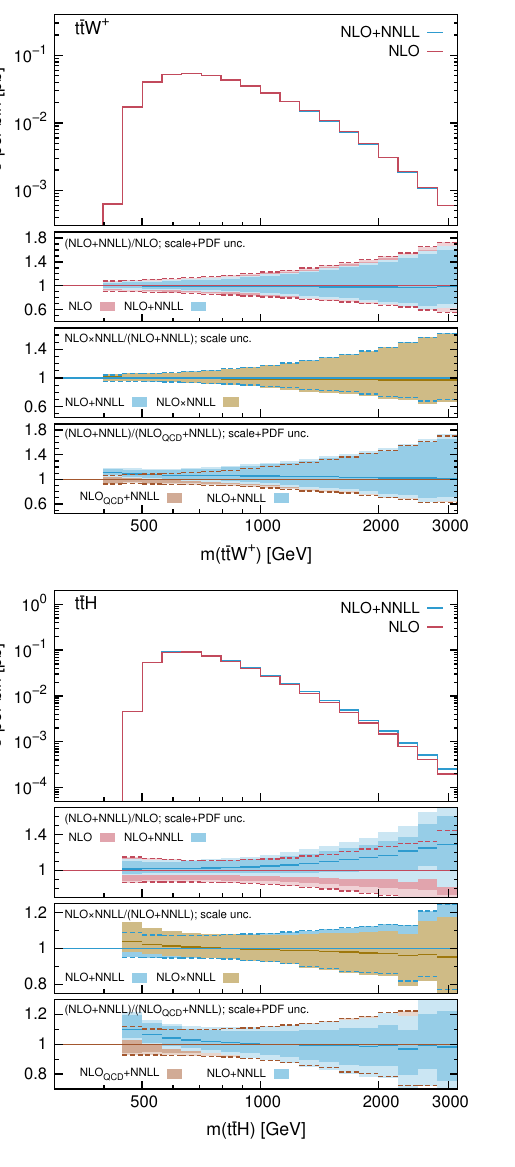
Figure 2 . Distribution of the invariant mass of the t (cid:22) tV system at 13 TeV. The upper plots refer to t (cid:22) tW + (left) and t (cid:22) tW (cid:0) (right), while the lower ones to t (cid:22) tH (left) and t (cid:22) tZ (right). In the (cid:12)rst inset we focus on the resummation e(cid:11)ects (NLO vs. NLO+NNLL), in the second one on the di(cid:11)erence between the additive and multiplicative approach (NLO + NNLL vs. NLO (cid:2) NNLL) including only scale uncertainties, and in the third on the impact of EW corrections (NLO QCD + NNLL vs NLO + NNLL). More details can be found in the main